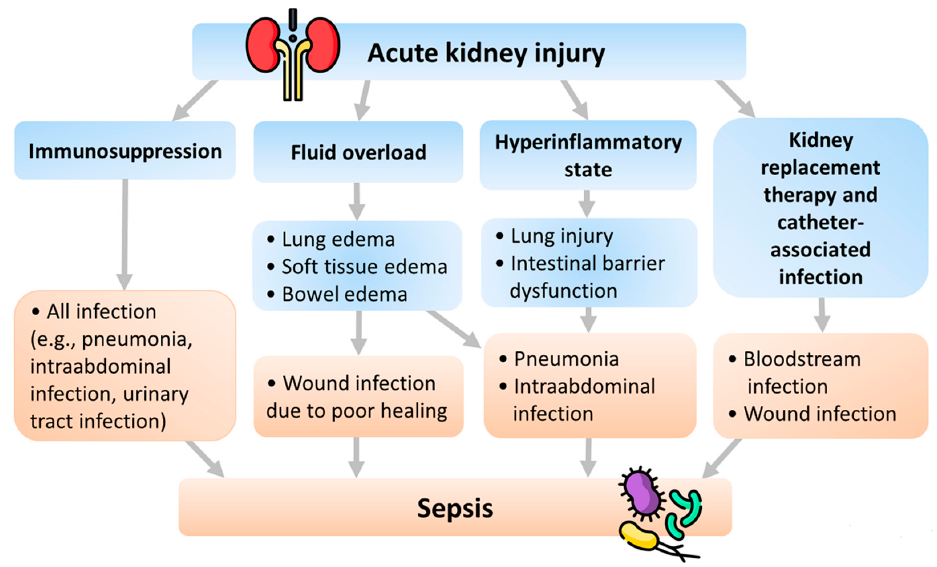
Figure 2. Pathophysiology of sepsis following AKI.